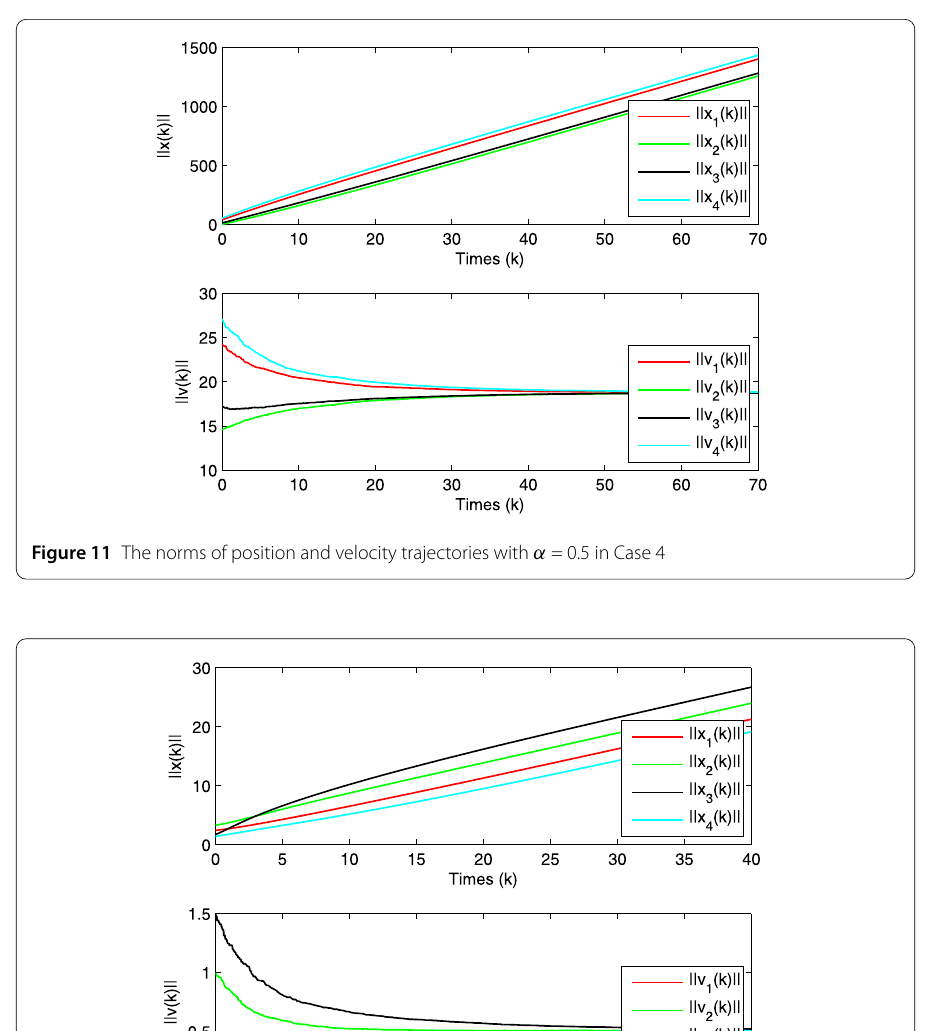
be a binary-valued process that is independent of { ξ ( k ) } k ∈ N